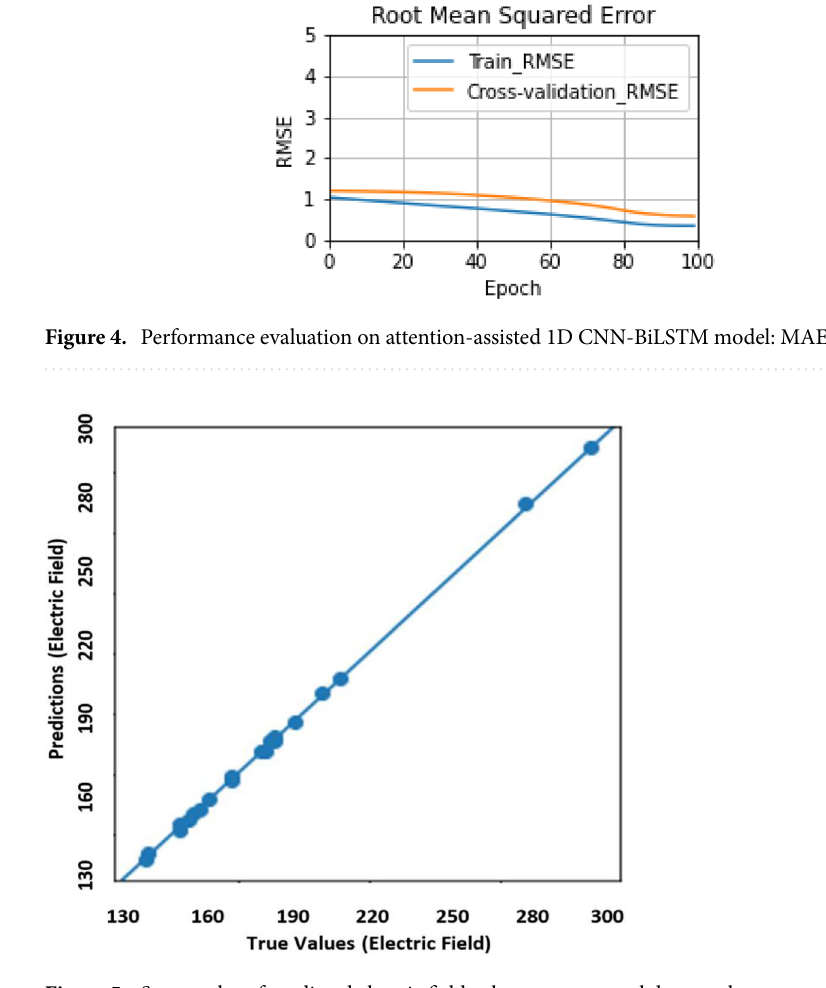
Figure 5. Scatter plot of predicted electric field values versus actual data on the test